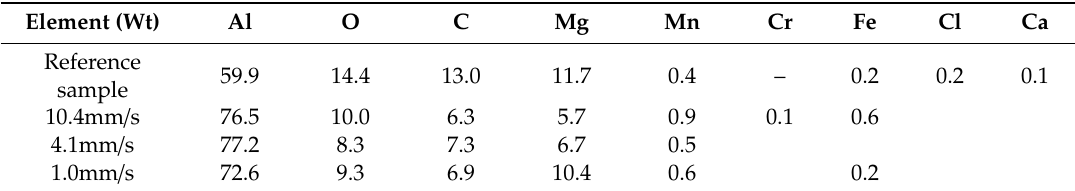
Table 4. Element content of aluminum alloy samples at di ff erent speeds by an energy dispersive spectrometer